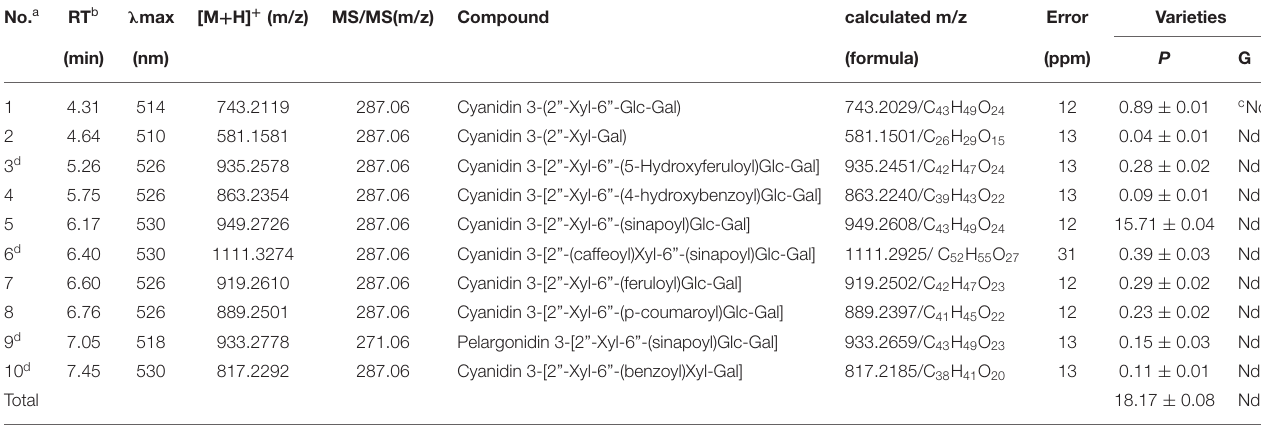
a No corresponds to the chromatographic peaks shown in Figure 1 . b RT, retention time. c Nd, not detected. G, Florence. P, Bronze. d Anthocyanins identified in fennel for the first time. Xyl, Glc, and Gal indicate xylose, glucose, and galactose, respectively.